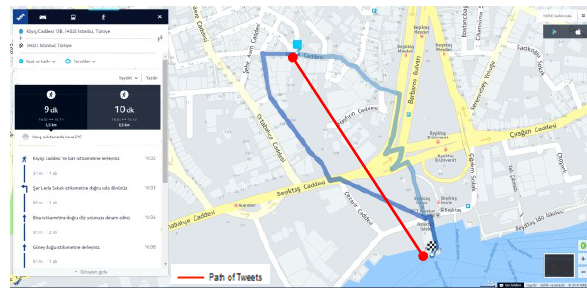
Figure 9. Even though, the assumptions on the pedestrian paths